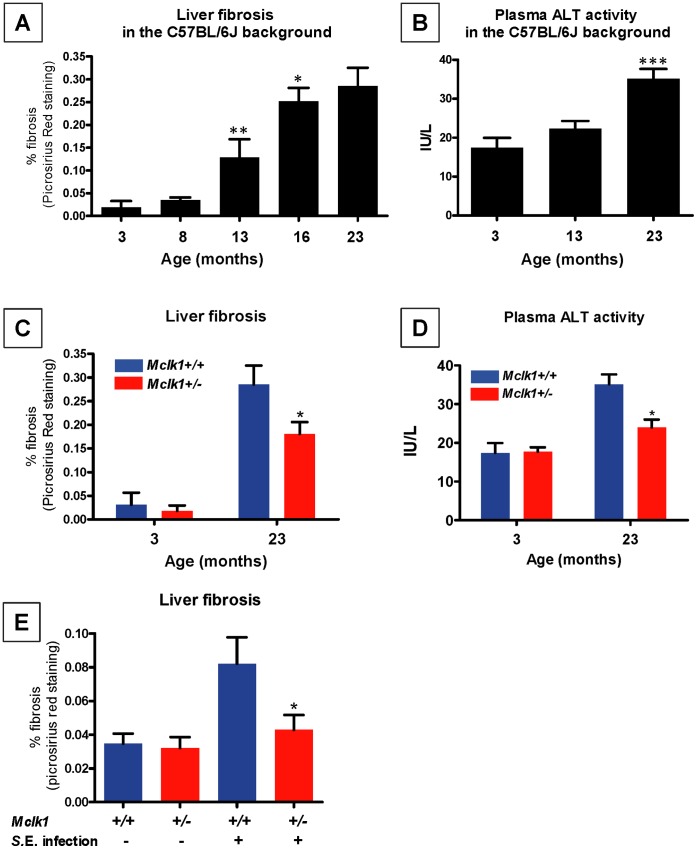
Favorable effects of the Mclk1
+/− genotype on fibrosis and plasma ALT levels during aging and after repeated S. Enteritidis infection.
A. The Level of liver fibrosis in wild type C57BL/6J mice of different age was determined. Sample sizes were from 5 to 16 and the means ± S.E.M. of each age group is shown. The asterisks indicate statistical significance compared to the immediately younger age group by a t-test. * stands for P<0.05, ** for P<0.01, and *** for P<0.001. B. Plasma ALT activity of wild type C57BL/6J mice was measured and the mean ± S.E.M. of each age group is shown. Sample sizes were from 5 to 14. C. The level of liver fibrosis in young and old Mclk1
+/− mutants on the C57BL/6J background and their Mclk1
+/+ siblings was determined. Sample size was 5 for the 3 months-old cohort and from 17 to 20 for the 23 months-old cohort. D. ALT activity in Mclk1
+/− mutants and Mclk1
+/+ siblings on the C57BL/6J background was measured at 3 months and 23 months of age. There were 5 mice for each genotype in the 3 months-old cohort, and from 15 to 16 mice in the 23 months-old cohort. E. The level of liver fibrosis was determined after 3 rounds of S. Enteritidis infection. There were 11–16 mice in each group; the mean ± S.E.M. of each group is shown. The asterisks indicate statistical significance compared to the wild type group by a t-test. * stands for P<0.05. All experiments in this figure were carried out with even numbers of both males and females.